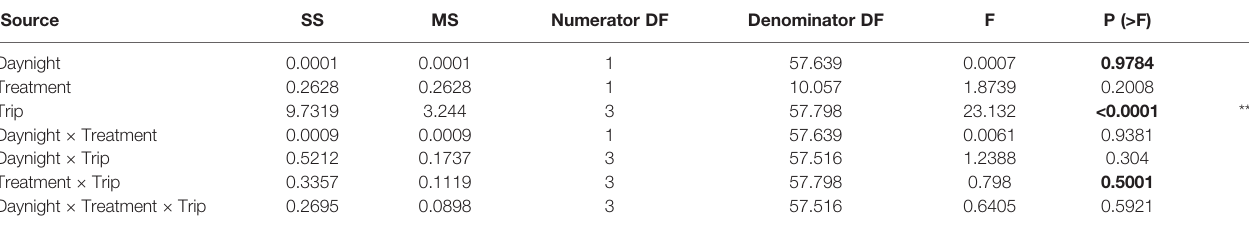
TABLE 3 | Linear mixed effects model for zooplankton abundance.